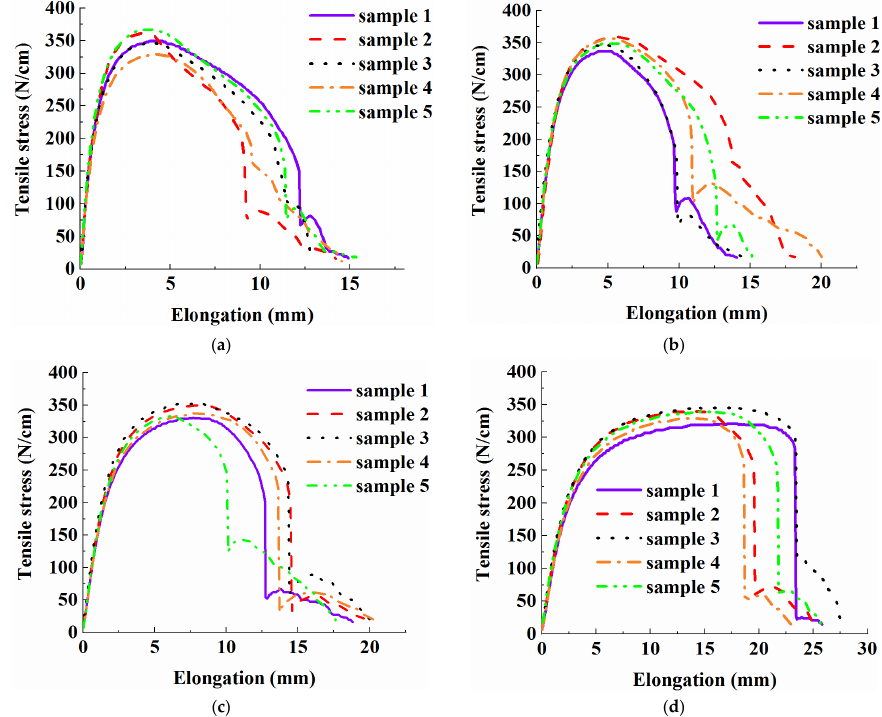
Figure 9. Tensile stress–elongation relationship of the junction subjected to uniaxial tension under various clamping distances: ( a ) 10.5 mm, ( b ) 25 mm, ( c ) 50 mm, ( d ) 100 mm. The failure modes of the junctions under tensile loading at different clamping distances can be observed in Figure 10. The failure modes of all the samples are similar. The fractures occurred at the spot-welding junction, and the strips had no visible change. This indicates that, during the tensile test, when the geocell strip has not begun to deform